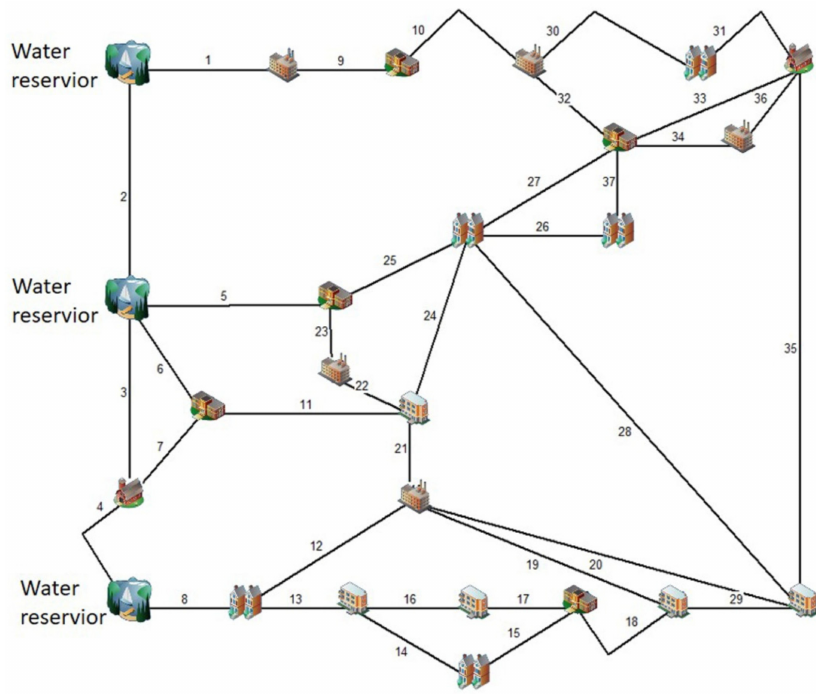
Figure 6. A WDS benchmark for PRV localization [43,44].